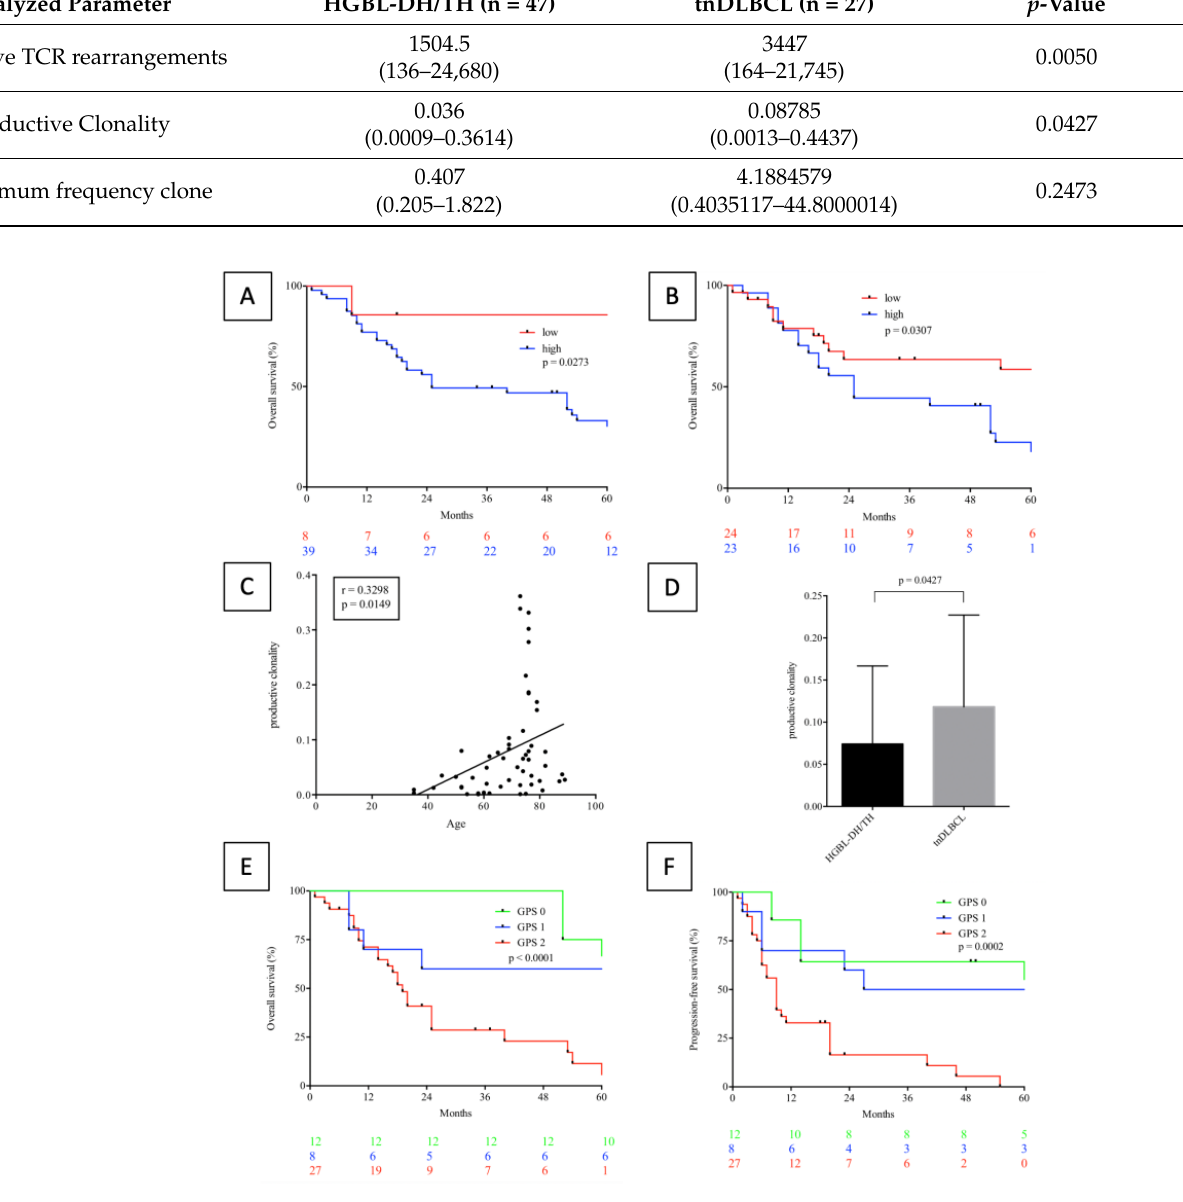
Figure 4. Clinical impact of the TCR repertoire clonality in HGBL-DH/TH. Overall survival